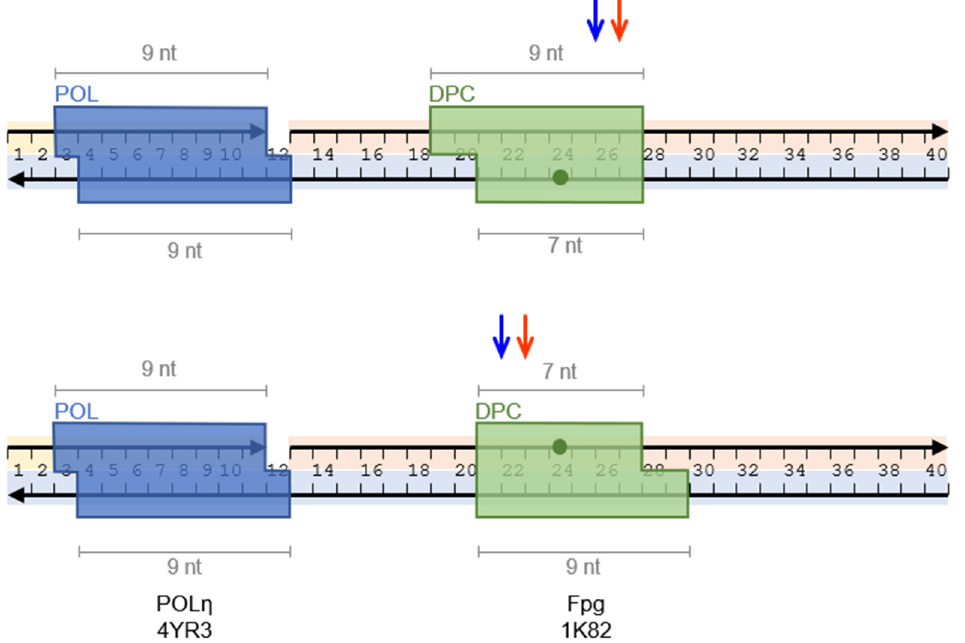
Figure 4. An arrangement of hPOL η and cross-linked Fpg on DNA with the sizes of the proteins estimated from the structural data. PDB IDs are 1K82 for the structure of Fpg [42] and 4YR3 for the structure of hPOL η [78]. Arrowheads mark the 3 ′ termini of the oligonucleotides. The green dots indicate the sites of cross-linking. The colored arrows indicate the termination positions of hPOL η while Fpg is cross-linked with the template strand (top panel) or the displaced strand (bottom panel). The blue arrows mark the positions of the last incorporated dNMP, the red arrows show the corresponding positions of the estimated front sides of hPOL η .